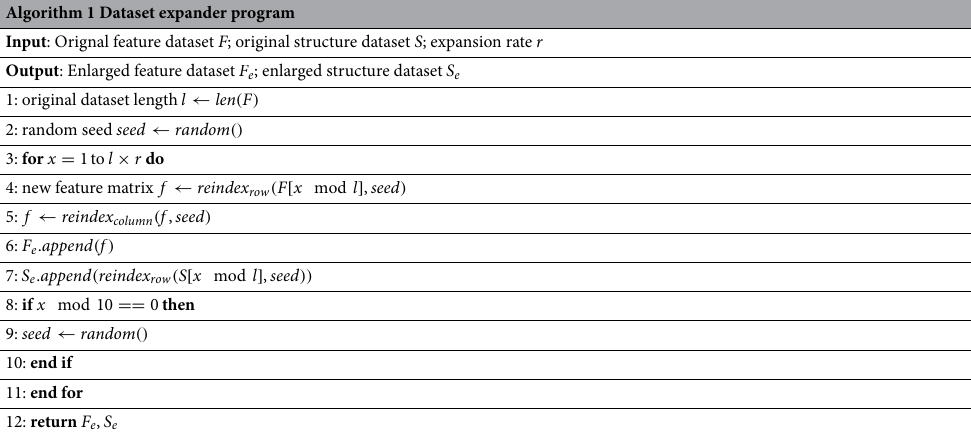
Algorithm 1 Dataset expander program